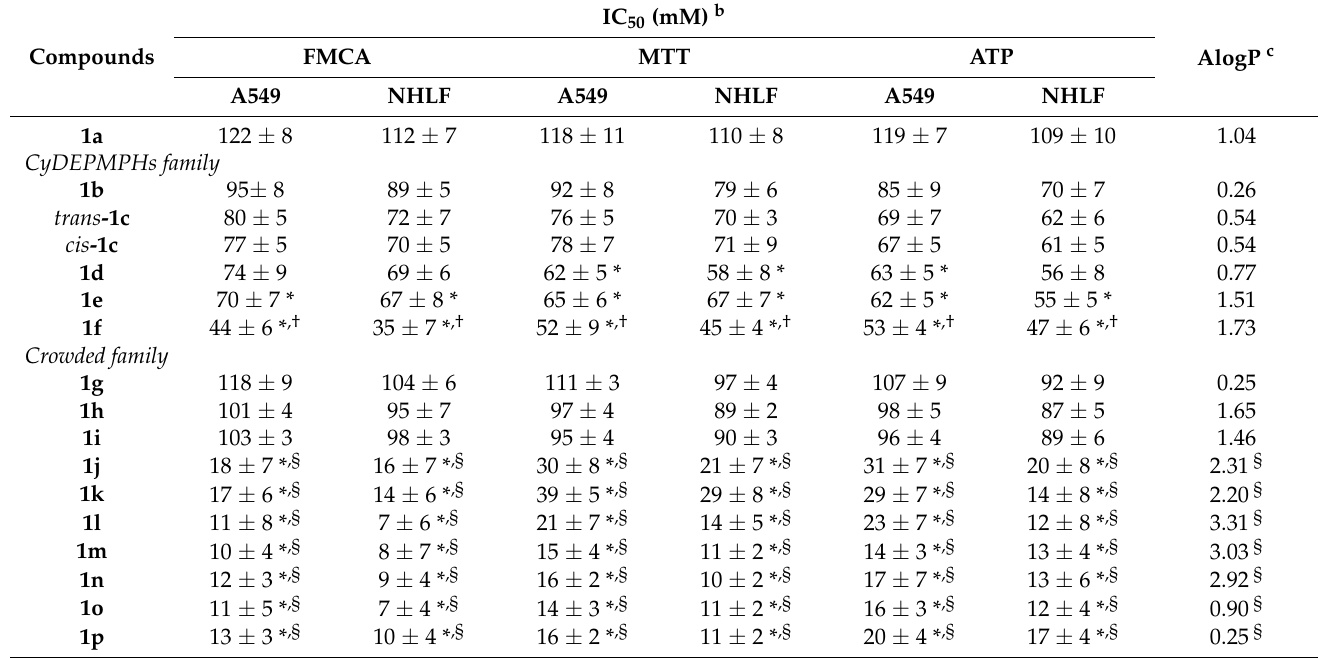
Table 3. Cytotoxicity of α -Aminophosphonates Against A549 Cells and Normal Human Lung Fibroblasts (NHLF) a , and their Calculated